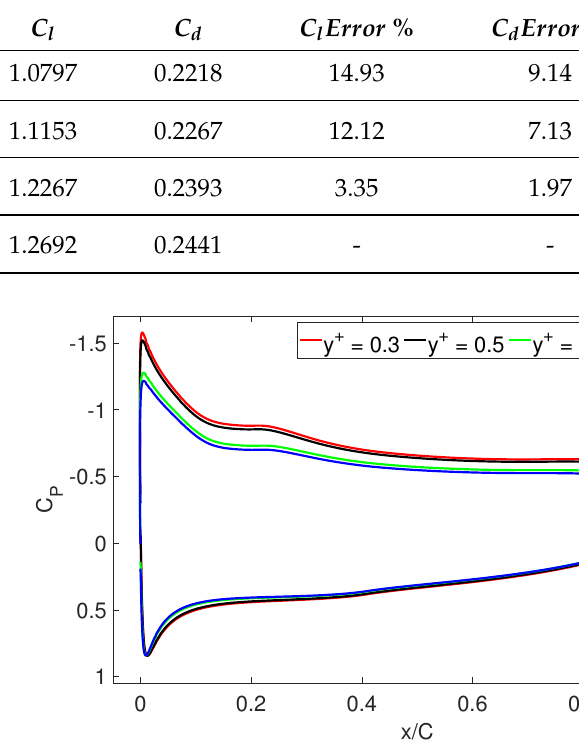
Table 2. Mesh candidates for the Mesh Independence Test.